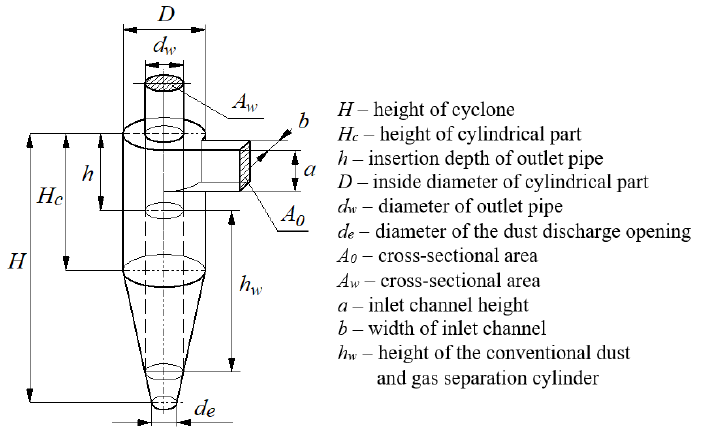
Figure 6. Characteristic dimensions of a tangential inlet return cyclone.